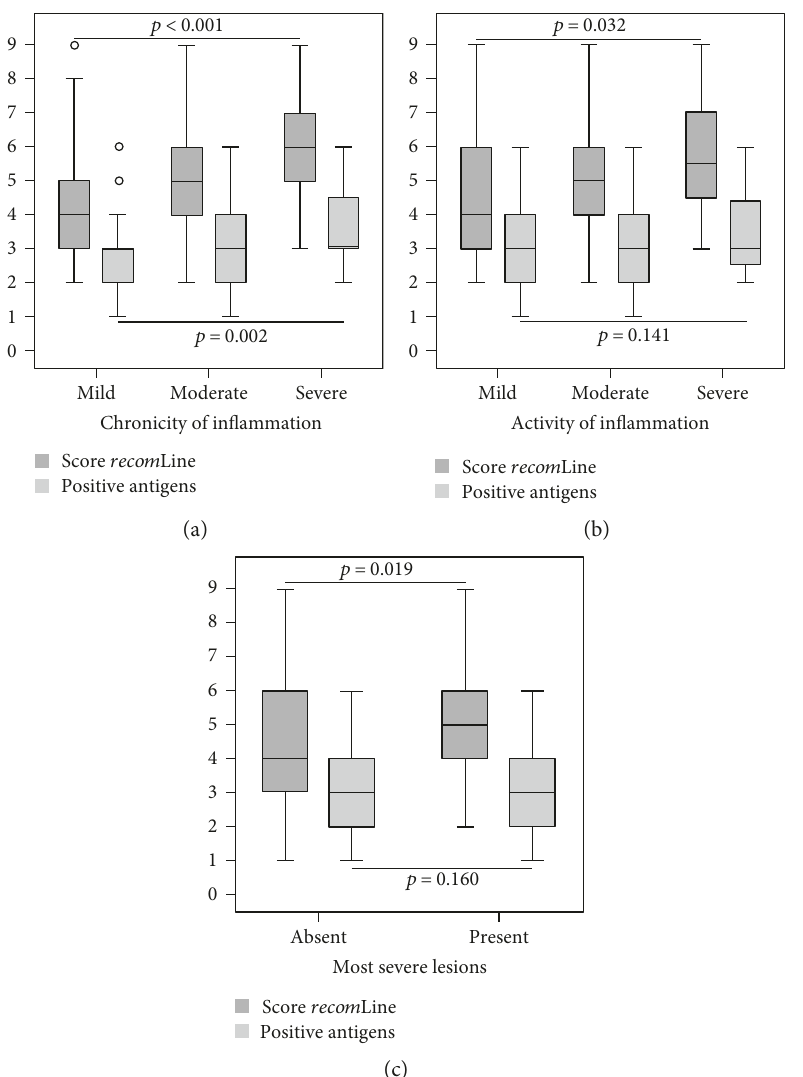
Figure 2: Box plot diagrams showing the association between recom Line test results (dark grey: score recom Line/light grey: number of positive antigens) and histological fi ndings in H. pylori positive cases. (a) Correlation between recom Line test results and the chronicity of in fl ammation ( n = 391 ). (b) Correlation according to the activity of in fl ammation ( n = 389 ) as well as (c) pathological fi ndings ( n = 95 ) according to histology. Data are presented as box plot showing the median, 75th and 25th percentile, outlier, and extreme values. Signi fi cances were calculated using the Kruskal-Wallis test. The results show a signi fi cant correlation between the achieved recom Line score and histological fi ndings. The sum of positive antigens only correlates signi fi cantly with the chronicity of in fl